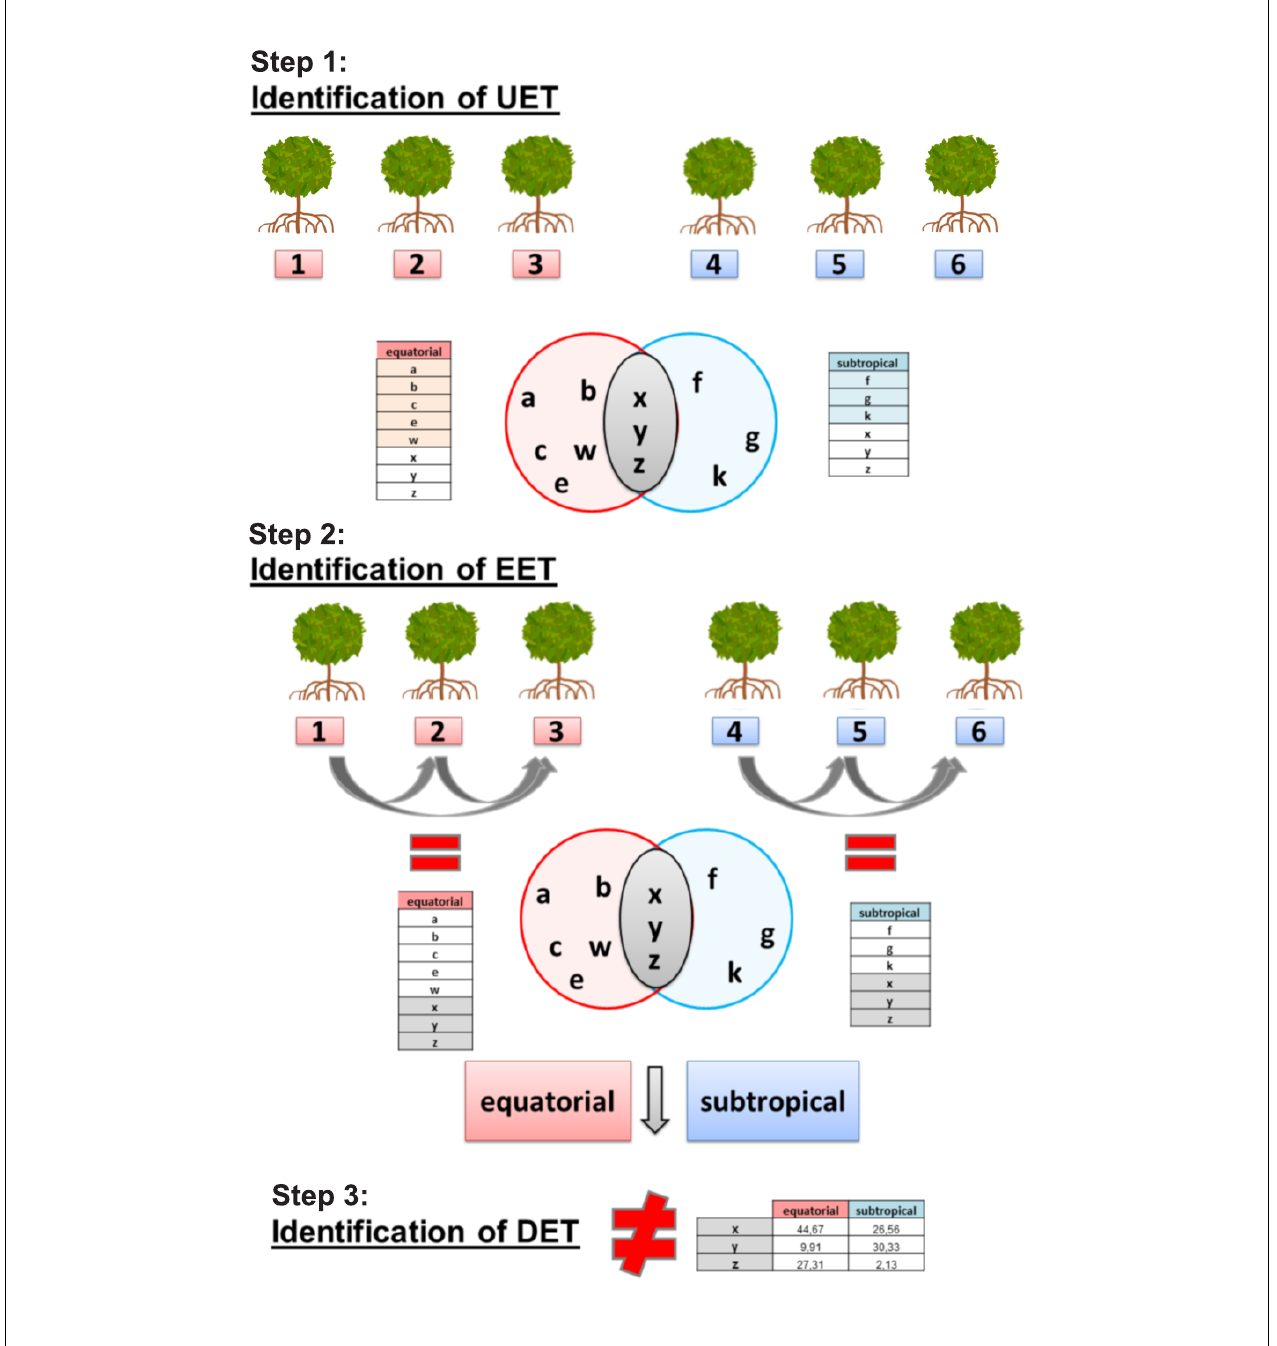
FIGURE 3 | Differential expression analysis pipeline used in this work. (Step 1) Identification of uniquely expressed transcripts (UETs) in each population and subsequent selection of transcripts expressed in individuals from both populations to be used in step 2. (Step 2) Identification of equally expressed transcripts (EETs) (5% of false discovery rate) between each pair of individuals from each population and subsequent selection of transcripts expressed in individuals from both populations to be used in step 3. (Step 3) Identification of differentially expressed transcripts (DETs) (5% of false discovery rate) between the two populations.